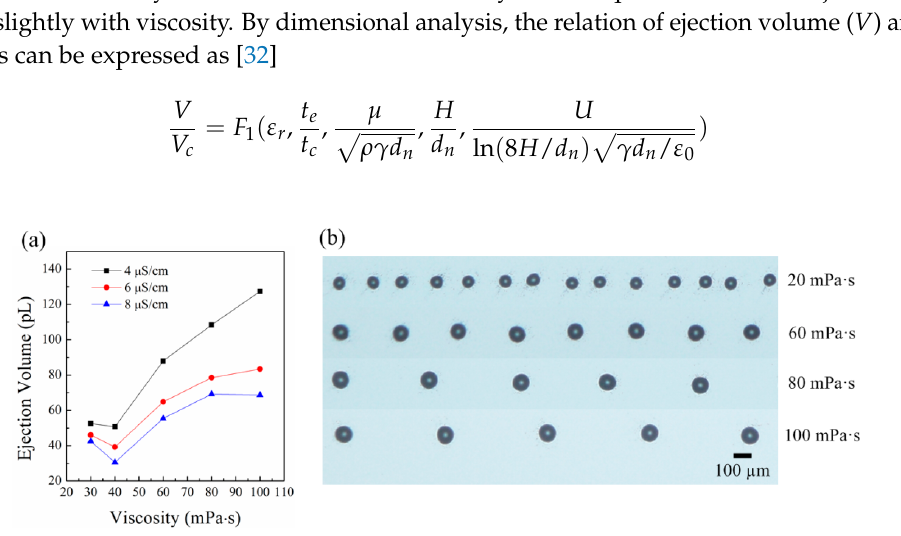
Figure 2. The ejection volumes for liquids with different viscosities: ( a ) the relation of ejection volume and viscosity; ( b ) the printed droplets on the substrate for liquids with different viscosities. The applied voltage was 2150 V. The nozzle-to-substrate distance was 1.5 mm. The moving speed of the substrate was 20 mm/s.